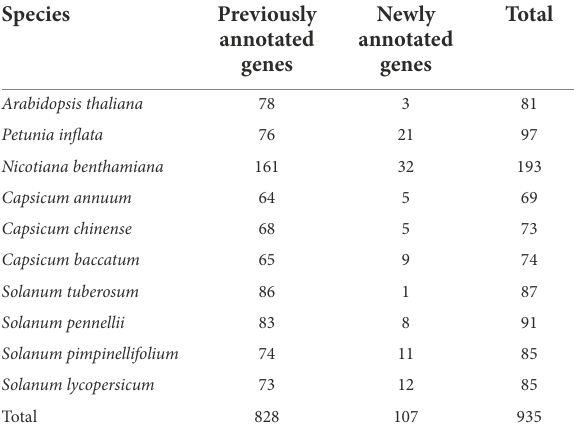
TABLE 1 Numbers of re-annotated bZIP genes in nine Solanaceae species and Arabidopsis thaliana